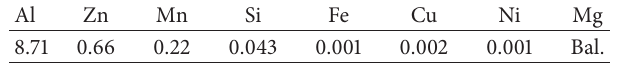
Table 1: Chemical composition (in wt.%) of AZ91 Mg-alloy.